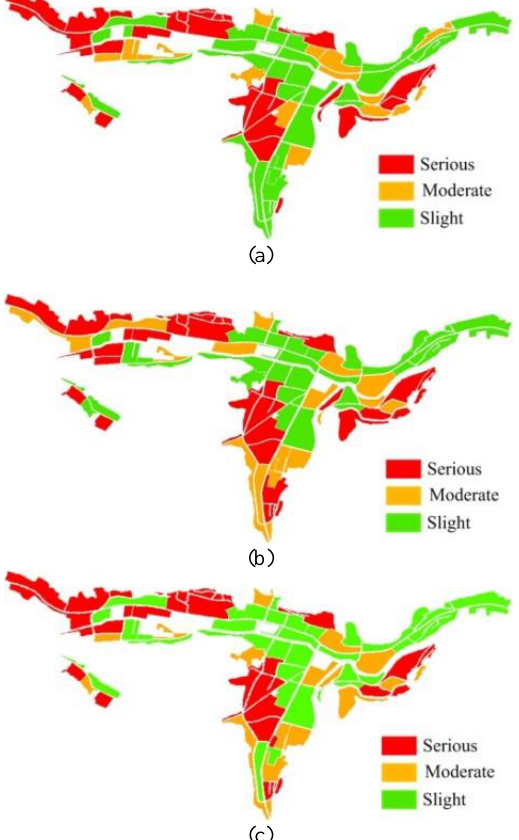
Figure 4. The building collapse assessment map: (a) VV; (b) HH/HV; (c) Full-polarization SAR Basically, the severe damaged areas on the three alluvial fans and the mildly damaged areas on the northeast corner